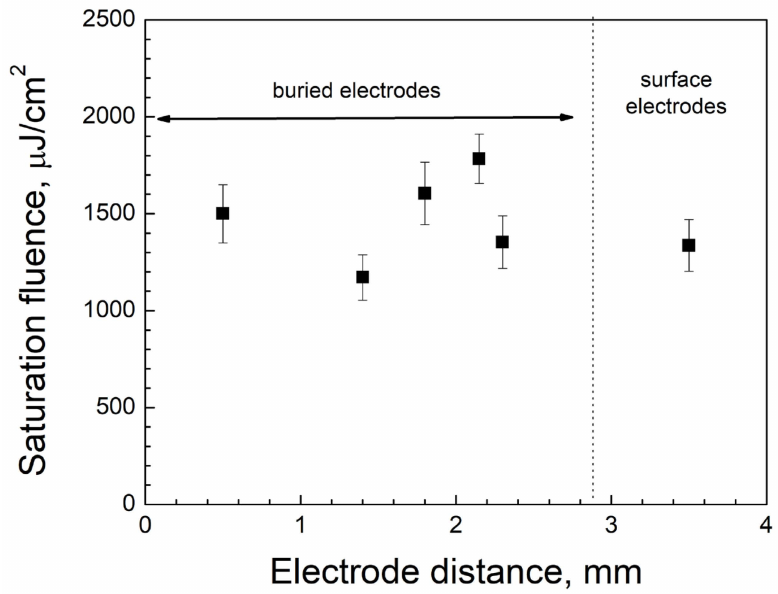
Figure 4. Saturation optical fluence for PCAs with different electrode